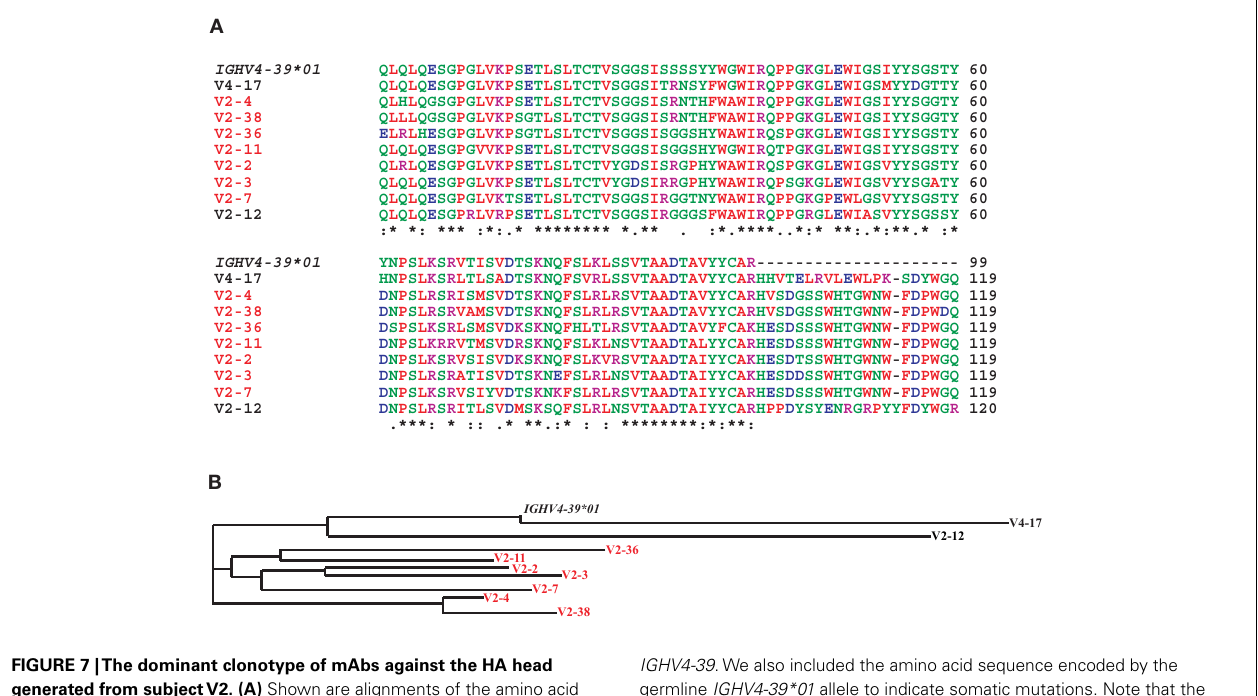
FIGURE 7 |The dominant clonotype of mAbs against the HA head generated from subjectV2. (A) Shown are alignments of the amino acid sequences of the variable region of the H chain of the dominant clonotype fromV2 using the IGHV4-39 , another mAb against the HA head fromV2 also using IGHV4-39 , and a mAb against the HA head fromV4 also using